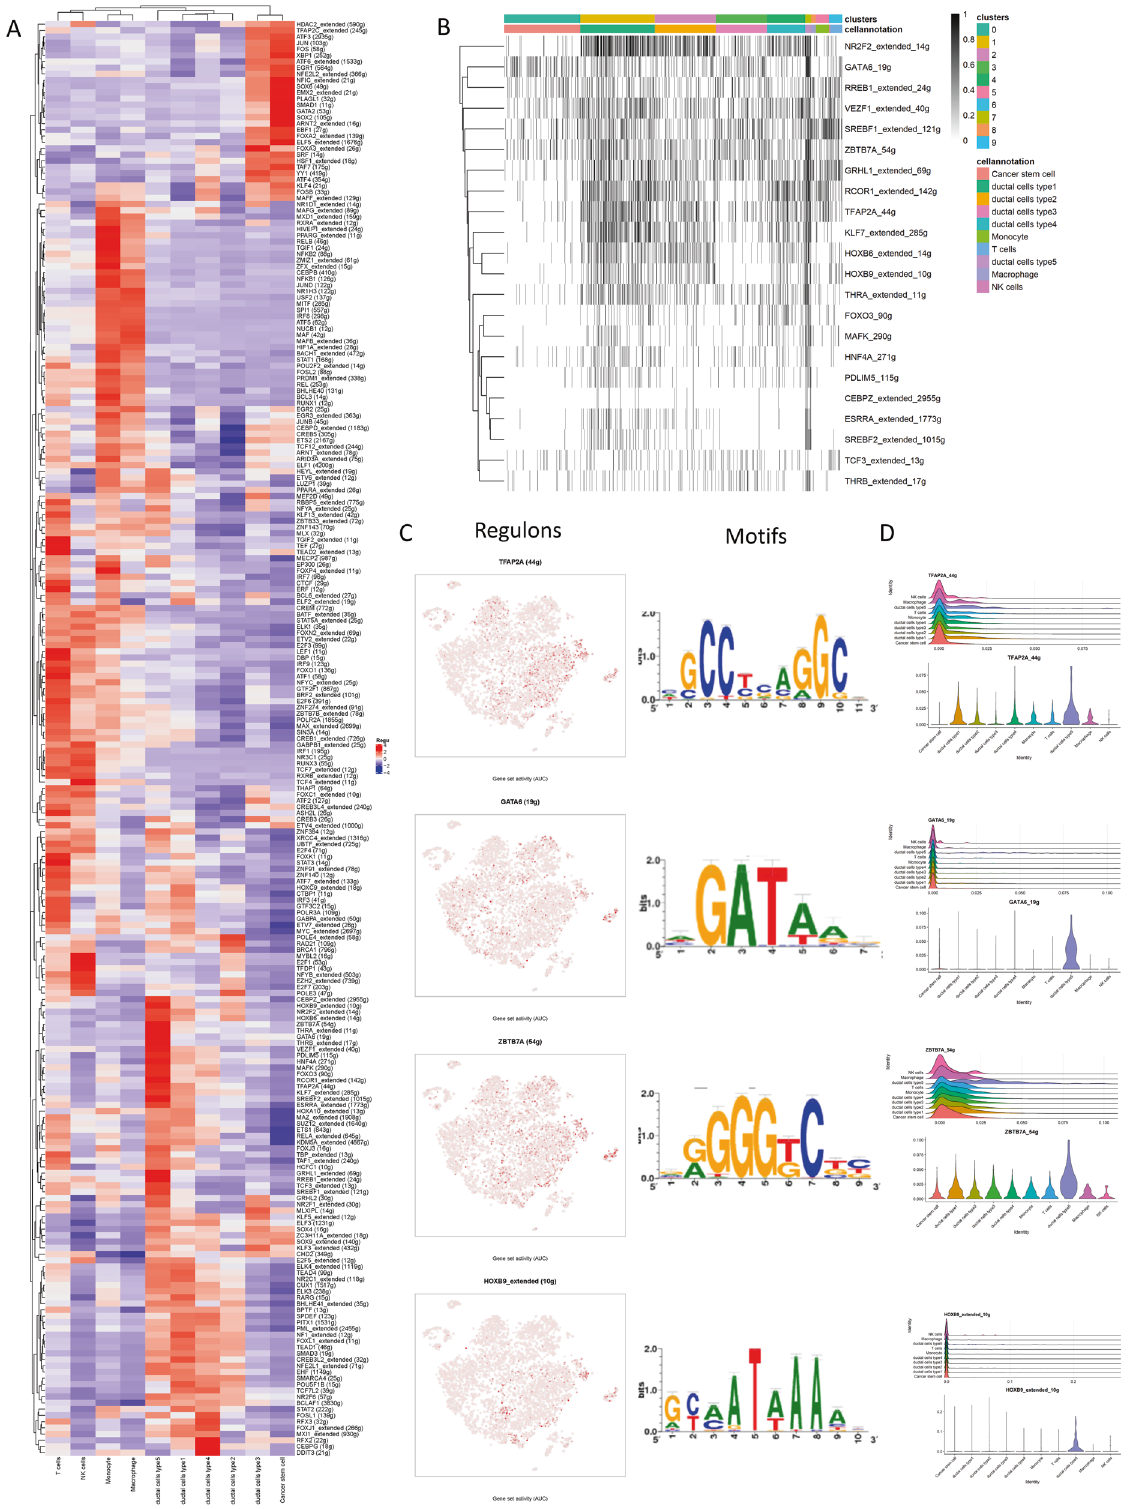
Fig. 7 Speci fi c transcription factors involved in malignant progression. A The heatmap exhibits the average regulon activities of transcription factors in different cellular types, color key from blue to red indicates relative expression levels from low to high. B Heatmap of regulon activity analyzed by SCENIC with default thresholds for binarization. The “ regulon ” refers to regulatory network of TFs and their target genes. “ On ” indicates active regulons; “ Off ” indicates inactive regulons. C The t-SNE plot shows the top four highly expressed transcription factors in type 5 ductal cells, and part of their motifs were listed in the right panel. D Violin plots showing distributions of representative TFs expression among different cell types.